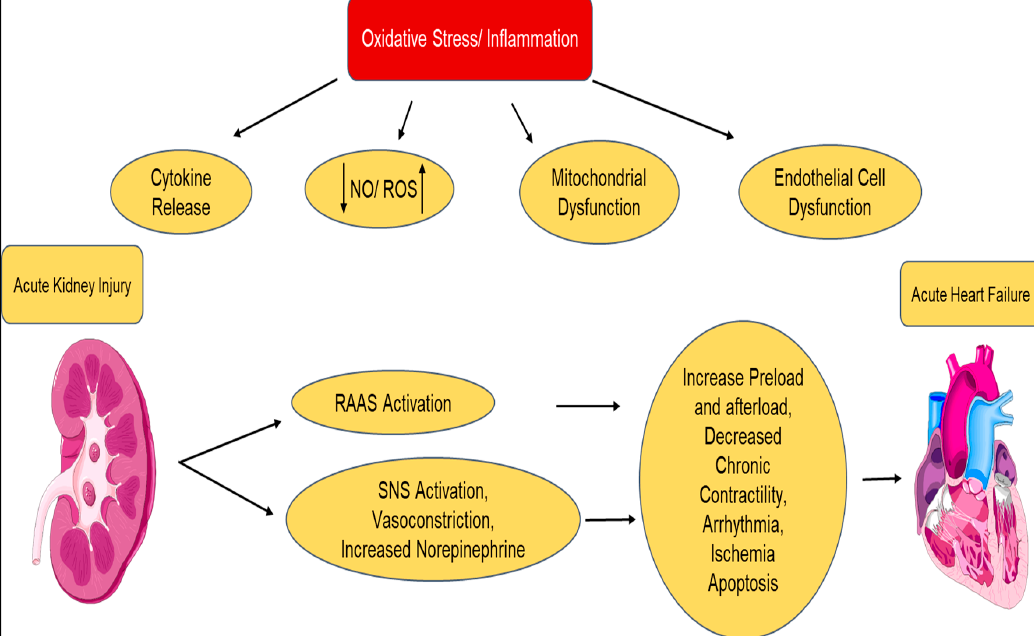
Figure 4. Pathophysiology of renocardiac syndrome (type 3): mechanism involves an acute insult to kidney function that results in the acute sympathetic nervous system activating a cascade of inflammatory responses, causing acute heart failure. NO= nitrous oxide; RAAS= renin–angiotensin–aldosterone system; ROS= reactive oxygen species; SNS=sympathetic nervous system.